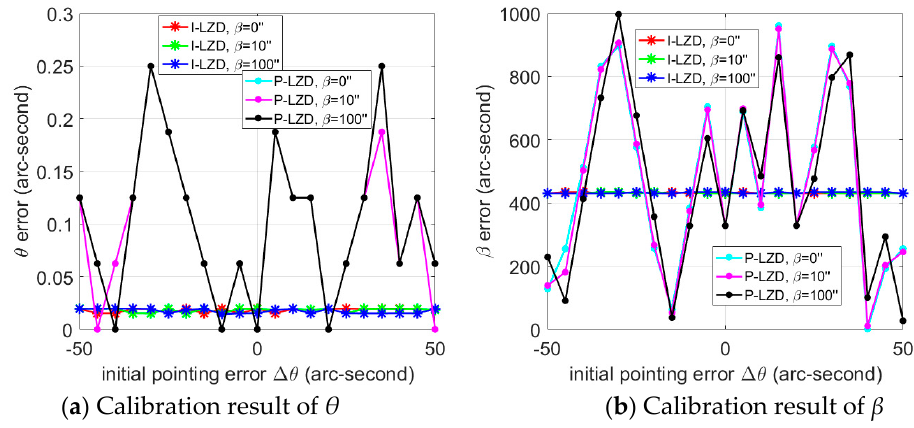
Figure 8. The calibration results of the P-LZD method and the I-LZD method based on different initial errors of θ and β ; 2.5 km length tracks were used. The range error ∆ ρ was set to be 0.